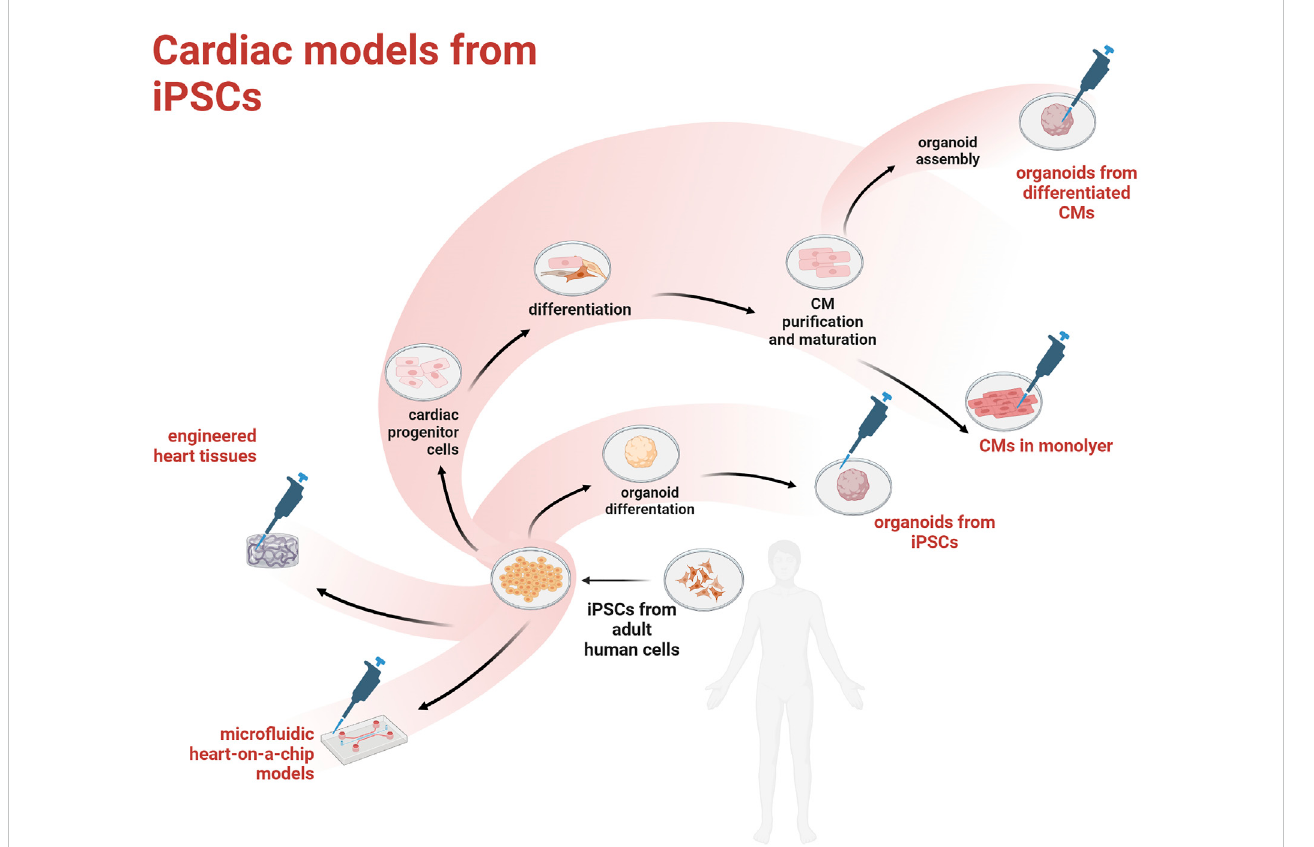
FIGURE 1 Overview of the main hiPSC-derived cardiac